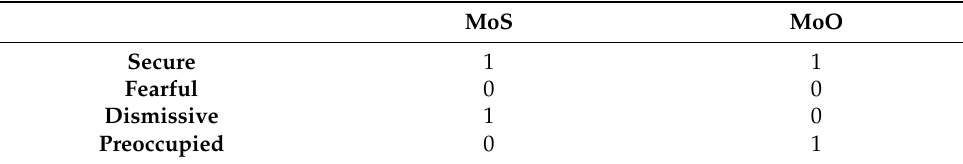
Table 2. Dummy variables for Model of Self (MoS) and Model of Others (MoO). MoS MoO Secure 1 1 Fearful 0 0 Dismissive 1 0 Preoccupied 0 1 Note: 1 indicates presence of positive MoS, MoO. 0 indicates presence of negative MoS,